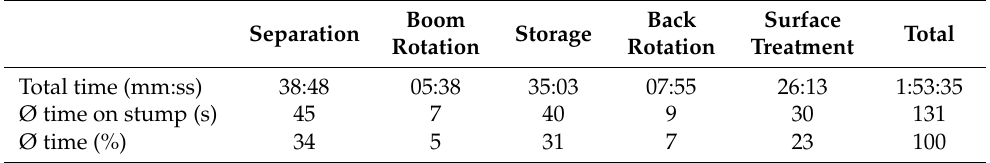
Table 6. Processing time of work operations.